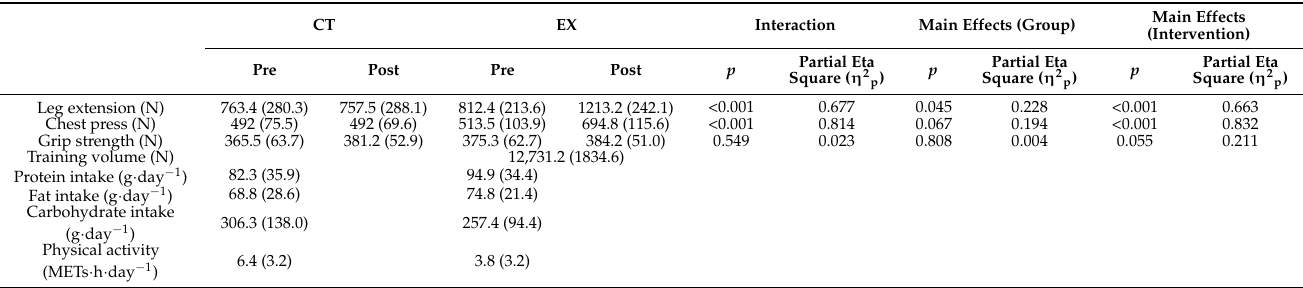
Table 2. Participants’ exercise training and dietary